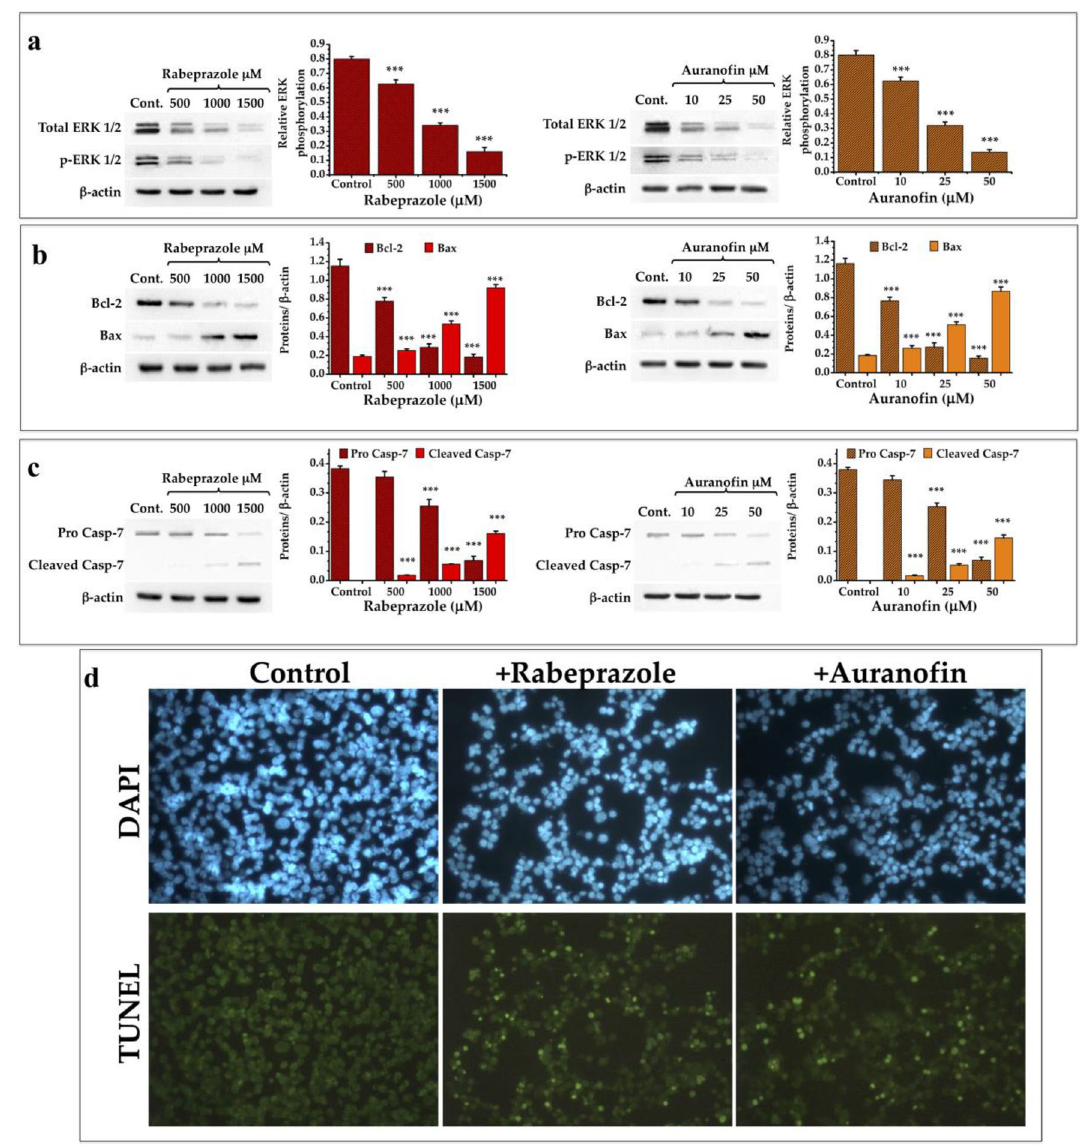
Figure 4. Expression of elements related to programmed cell death in cancer cells treated with thiol drugs. ( a ) Western blot analysis of the expression of ERK 1/2 and its phosphorylated form. Graphs depict the decrease of ERK 1/2 and its phosphorylated form under treatment with rabeprazole (red bars) and auranofin (orange bars). ( b ) Western blot analysis of the expression of Bcl-2 and Bax. Graphs depict the expression of these two elements under treatment with rabeprazole (red bars) and auranofin (orange bars). ( c ) Western blot analysis of the expression of pro caspase-7 and the apparition of its cleaved form. Graphs depict the relative quantities of these two forms of Casp-7 under treatment with rabeprazole (red bars) and auranofin (orange bars). β-Actin was used as a charge control. Differences among groups were assessed with one-way ANOVA and Tukey’s test with p value = 0.001 ***. ( d ) TUNEL assays of cancer cells do not treated (Control) or treated with 700 μM rabeprazole (+ Rabeprazole) or 70 μM auranofin (+ Auranofin). DAPI was used for nuclei staining. Photographs are at ×40. Full-length blots of ( a – c ) panels are shown in Suppl. Fig.